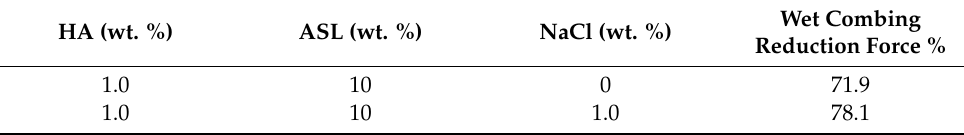
Table 5. Effect of HA Concentration with ASL on Wet Combing Reduction Force. HA (wt. %) ASL (wt.